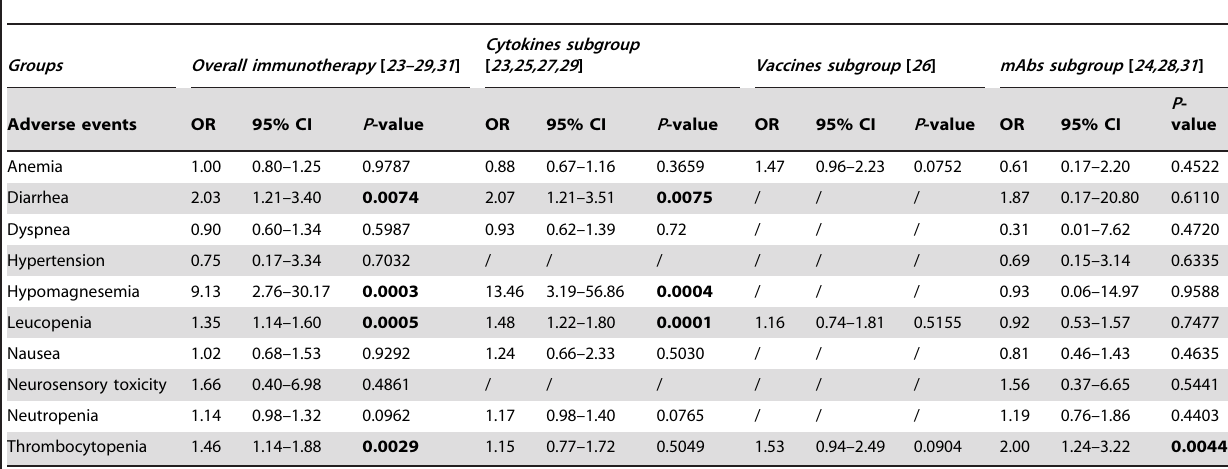
Table 5. Adverse events (grade $ 3) in overall immunotherapy and subgroups of advanced NSCLC patients.